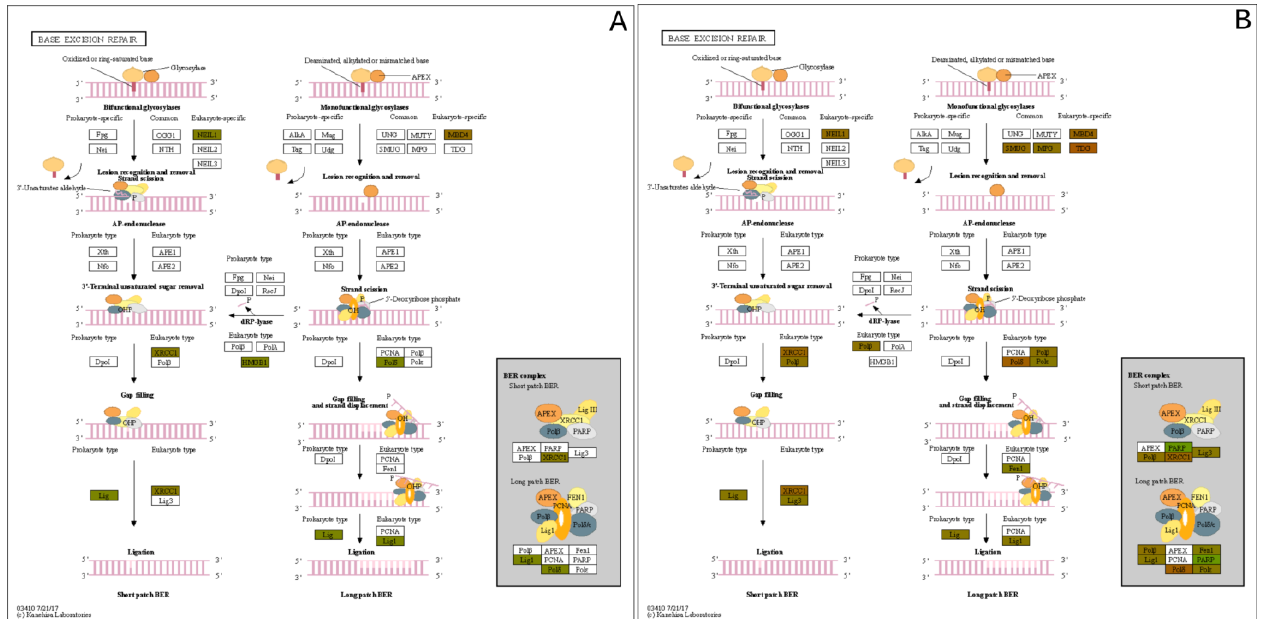
Figure 8. Base Excision Repair (BER) Pathway expression profiles of the ( A ) 3 h exposure and the ( B ) 24 h post exposure. ( B ) 24 h post